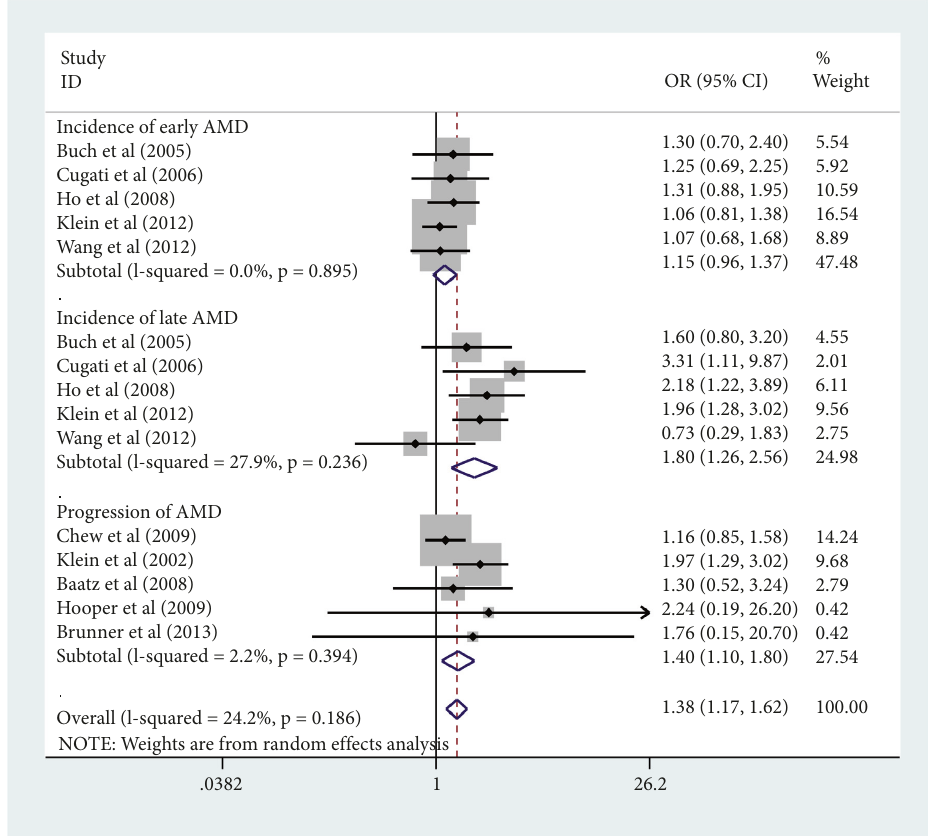
Figure 2: Risk estimates of the association between cataract surgery and the development and progression of age-related macular de- generation (AMD) in the overall Table 2: Subgroup analyses of cataract surgery and the incidence of age-related macular degeneration. Significance Heterogeneity Subgroups No. of studies Pooled OR 95% CI P value I 2 , (%) P value